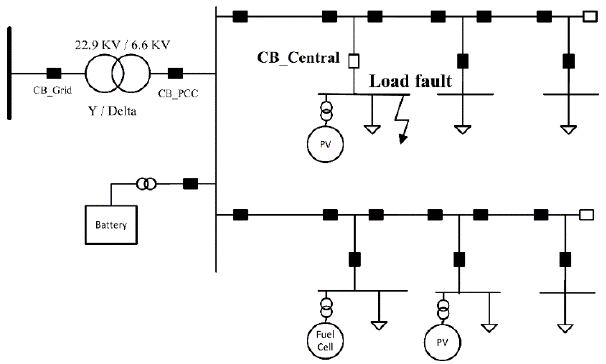
Figure 10. Microgrid load single line-to-ground (SLG) faults.